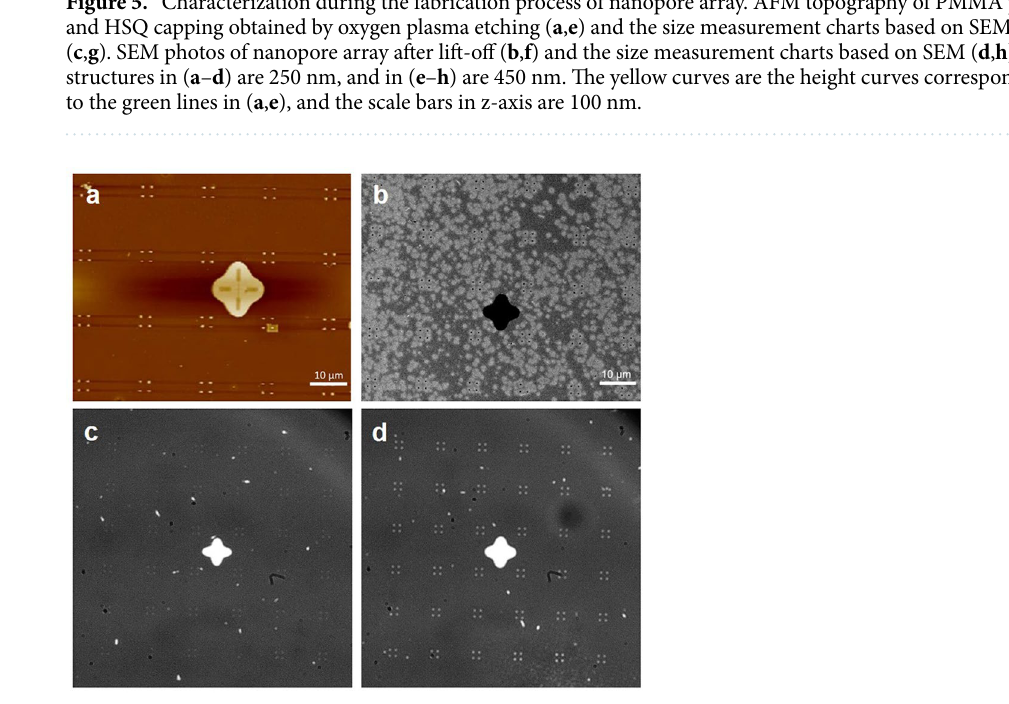
Figure 6. AFM topography of PMMA pillar and HSQ capping of the array obtained by oxygen plasma etching ( a ) and SEM photos of nanopore array after lift-off ( b ); Optically transparent nanofacula arrays with different apertures illuminated by white light ( c , d ). The structures in c are 250 nm, and in a, b and d are 450